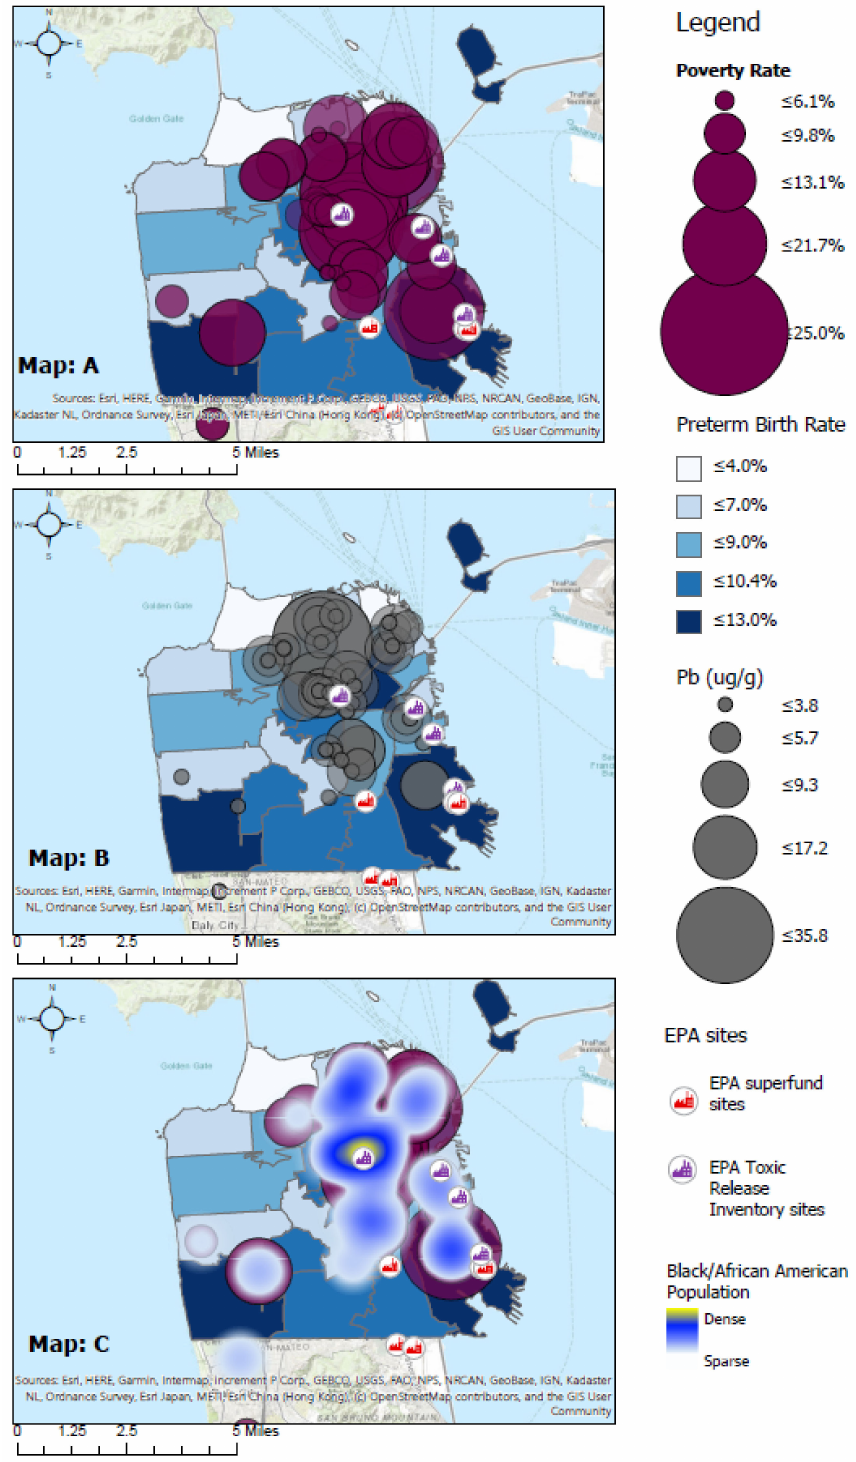
Figure 3. Geographic Distribution of Pb and Social Determinants in San Francisco by zip code. The layers are as follows: a polygon base layer of zip codes with their PTB rate in blue (Maps A – C ), a purple dot distribution of poverty rates (Maps A , C ), a grey dot distribution of Pb concentration Pb (ug/g) by hair salons (Map B ), and a heat map of African American/Black population density (Map C ). Black, red, purple icons (Maps A – C ) illustrate EPA sites. Note that zip code 94015 is shared with Daly City and only PTB data exist for Treasure Island), EPA = U.S. Environmental Protection